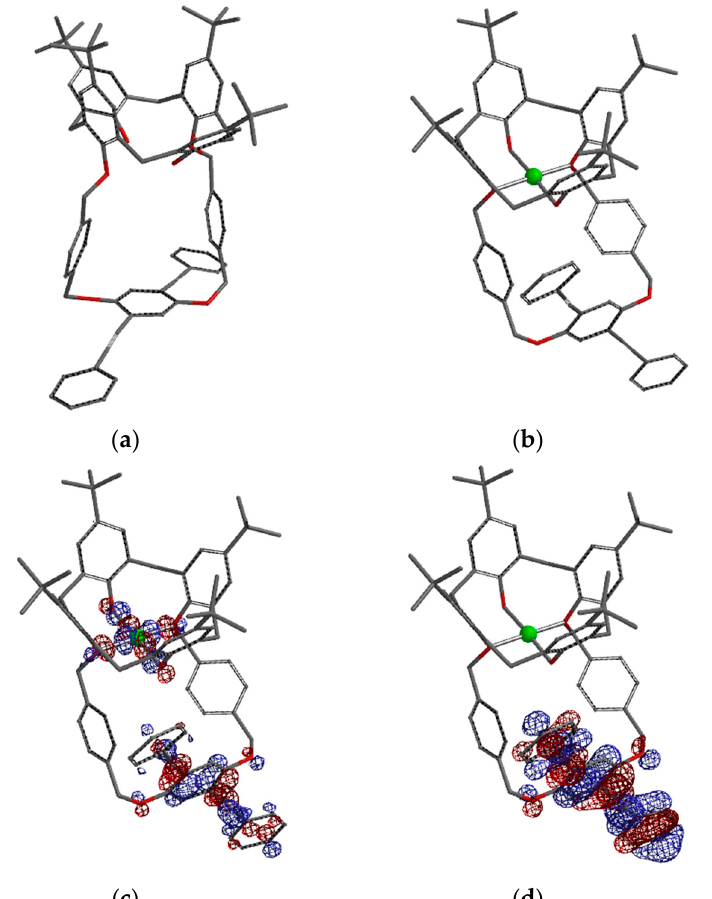
Figure 5. Energy and geometry optimised structures of Calix-OCP ( a ) and Calix-OCP-Cu(II) ( b ) models (side views). β -HOMO ( c ) and α -HOMO ( d ) molecular orbitals mapped on the structure of the complex (side views). DFT calculations run at the B3LYP/6-31G ( d ) level of theory in vacuum [44]. Hydrogens omitted for clarity. Colour codes for elements: red = oxygen, grey = carbon, green = copper.